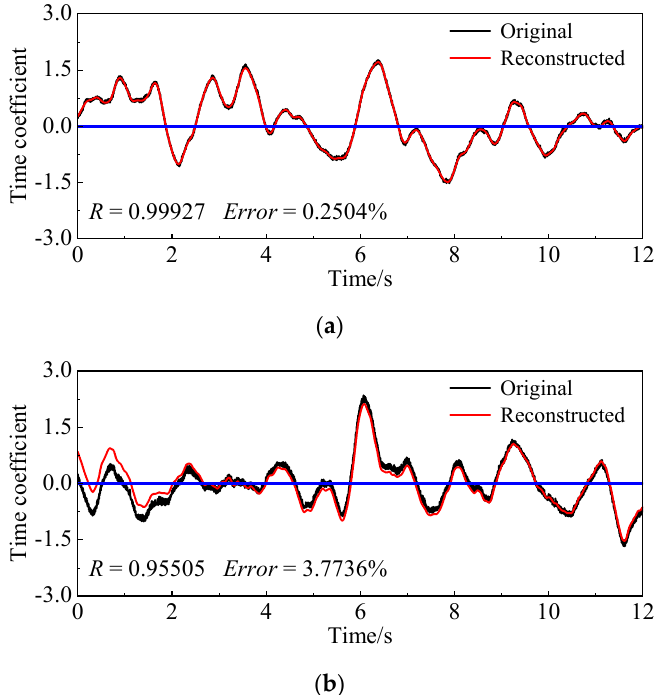
Figure 11. Correlation coefficient of each IMF and original signal: ( a ) None; ( b ) Control.